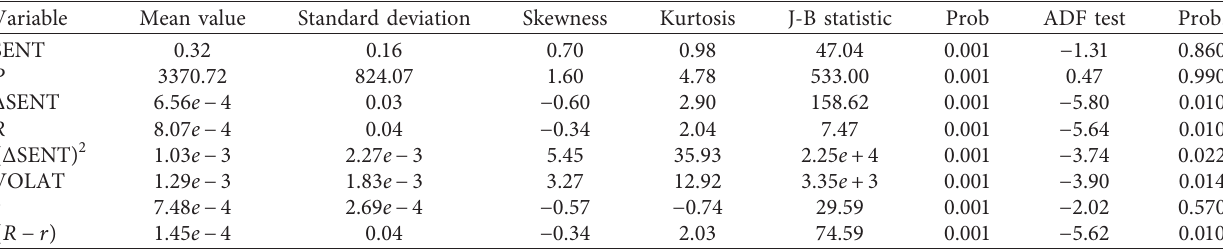
Table 1: Descriptive statistics of empirical